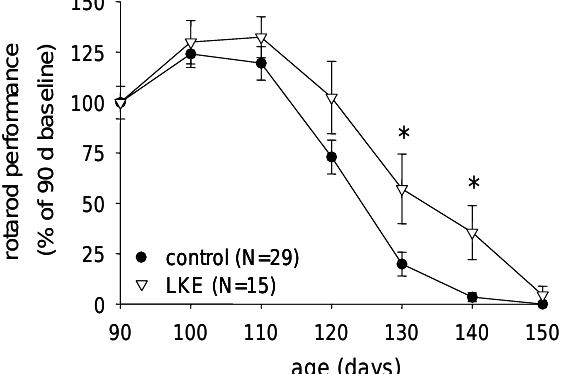
Rotarod performance curves are shown for mice injected intraperitoneally with 100 mg/kg/d LKE, beginning at 90 d. Bars represent mean ± SEM; * p < 0.05 by post-hoc two-tailed